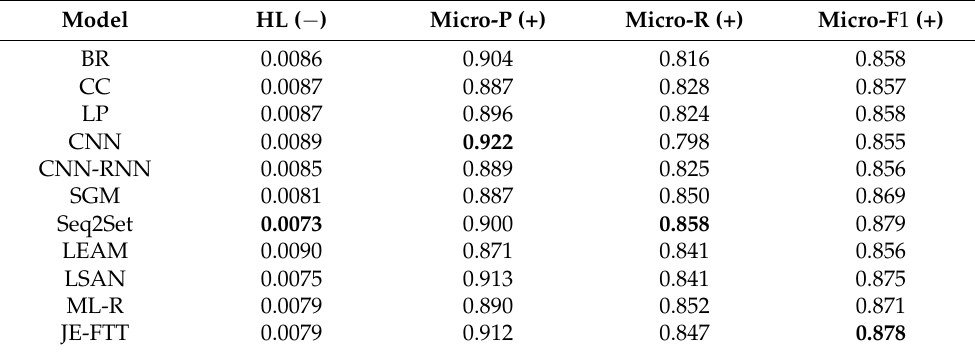
Table 4. Comparative experiments on the RCV1-V2